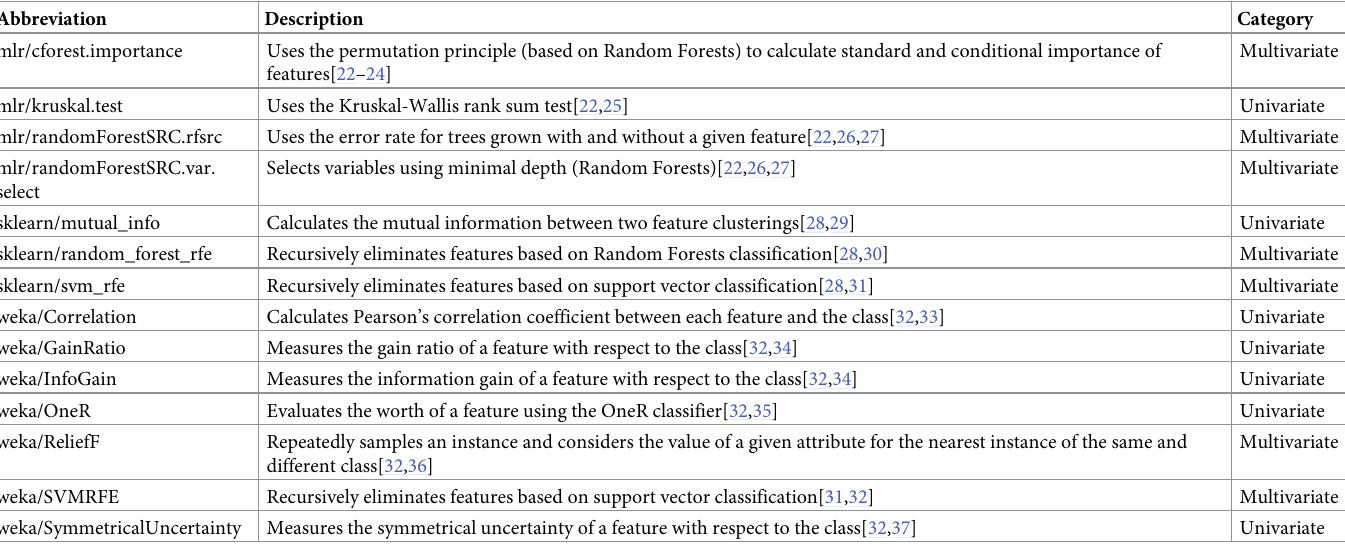
Table 1. Summary of feature-selection algorithms. We evaluated 14 feature-selection algorithms. The abbreviation for each algorithm contains a prefix that indicates which machine-learning library implemented the algorithm (mlr = Machine learning in R, sklearn = scikit-learn, weka = WEKA: The workbench for machine learning). For each algorithm, we provide a brief description of the algorithmic approach; we extracted these descriptions from the libraries that implemented the algorithms. In addi- tion, we assigned high-level categories that indicate whether the algorithms evaluate a single feature (univariate) or multiple features (multivariate) at a time. In some cases, the individual machine-learning libraries aggregated algorithm implementations from third-party packages. In these cases, we cite the machine-learning library and the third-party package. When available, we also cite papers that describe the algorithmic methodologies